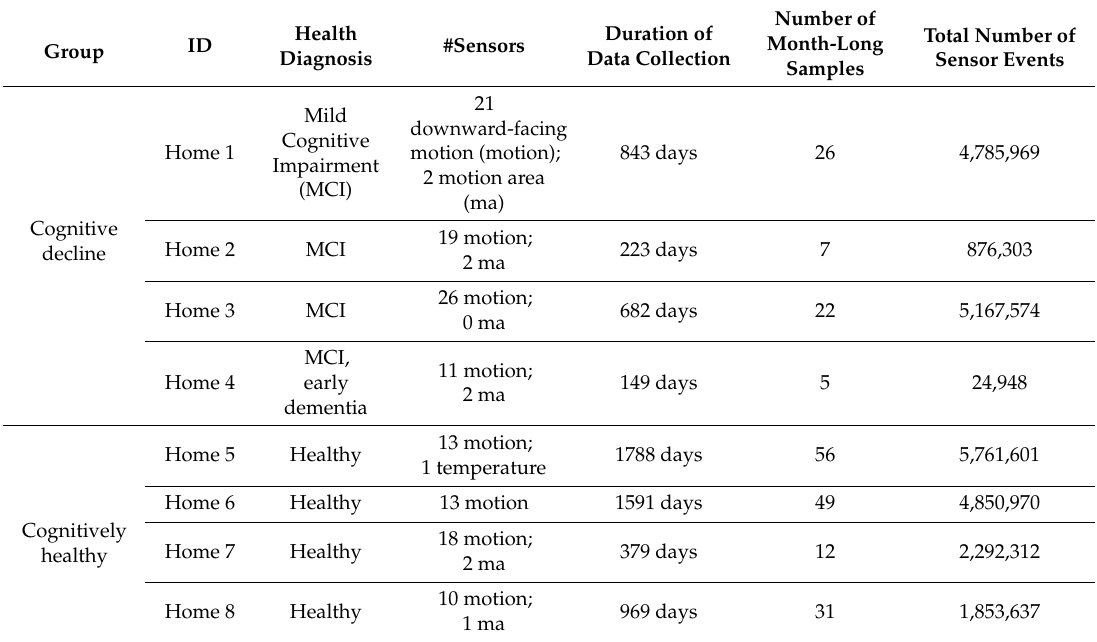
Table 3. Summary of information for eight smart home